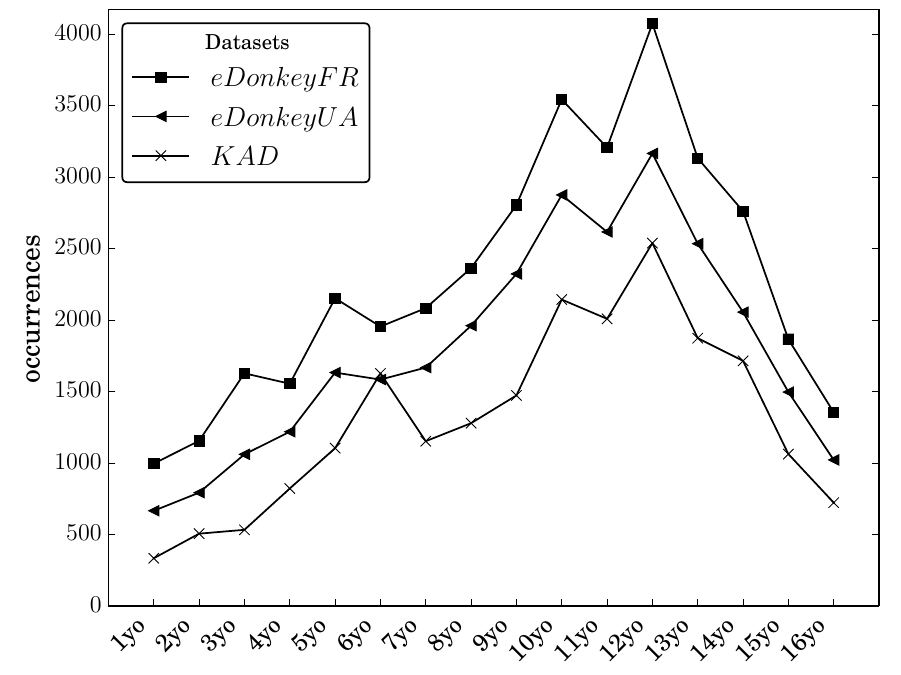
Figure 3. Distribution of age indicators in our three